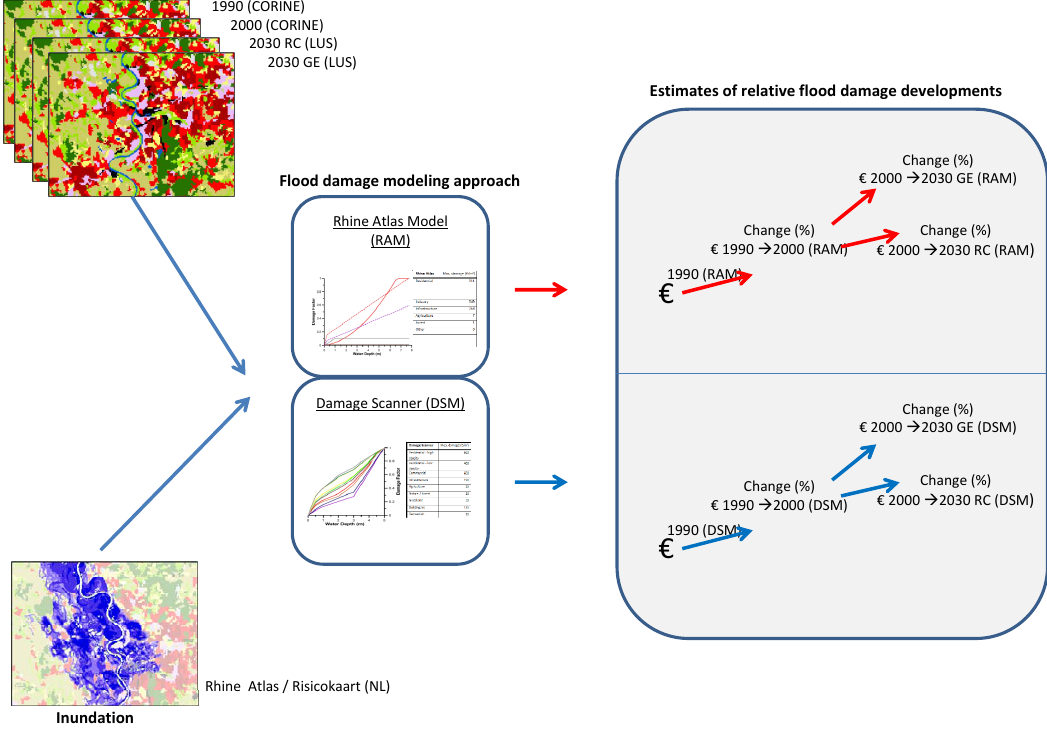
Fig. 1. Flow chart of the input data and method applied to evaluate the reliability of relative estimates of flood damage